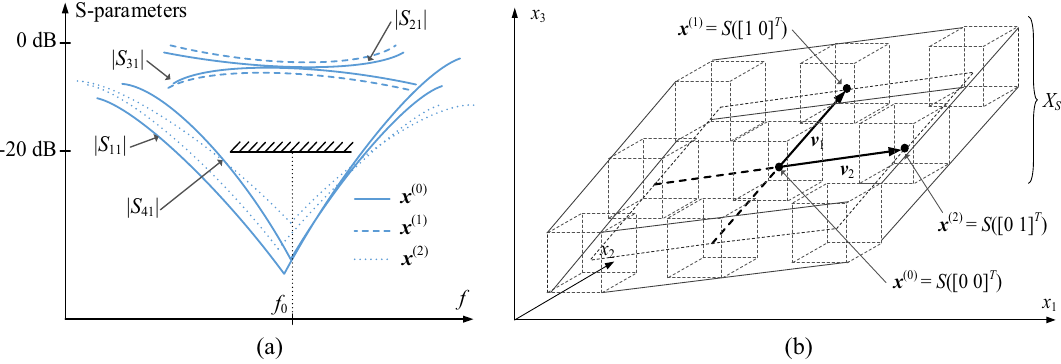
Figure 6. Performance-driven yield enhancement 21 : ( a ) S -parameters of a microwave coupler for design x (0) (nominal), design x (1) (degraded power split), and design x (2) (enhanced bandwidth at − 20 dB); for clarity, only relevant characteristics are shown; the directions important for yield manipulation are determined by designs x (1) and x (2) ; ( b ) surface S ( t ) parameterized by vector t = [ t 1 t 2 ] T is delimited by the designs x (0) , x (1) , and x (2) ; the model domain X S is a union of intervals S I ( t ) for − 1 ≤ t 1 , t 2 ≤ 1.